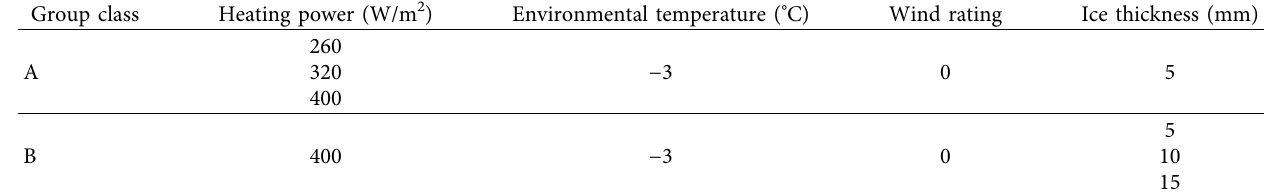
Table 5: Deicing test conditions.